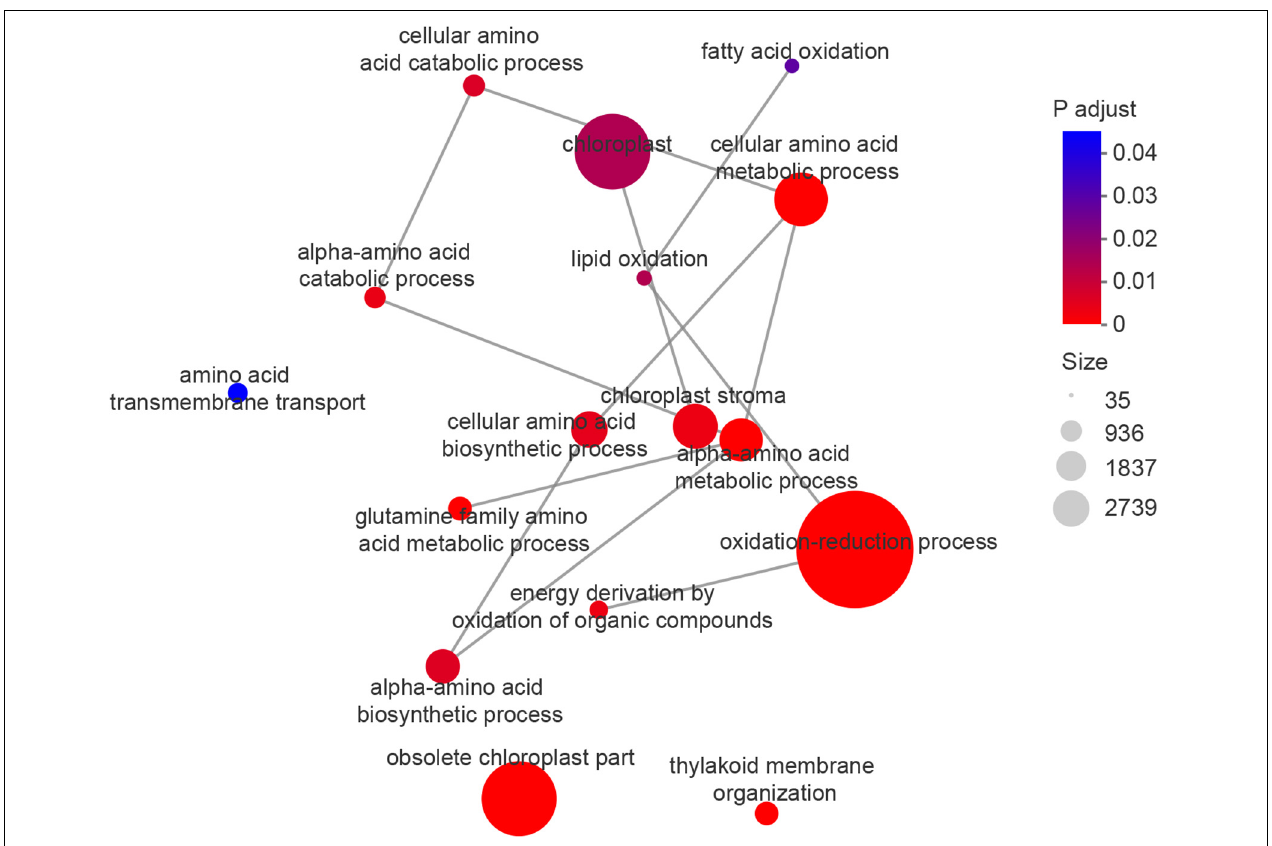
FIGURE 6 | Enrichment network map for GO terms ( Table 3 ), highlighting the relationship between GO terms and GO terms, GO terms and